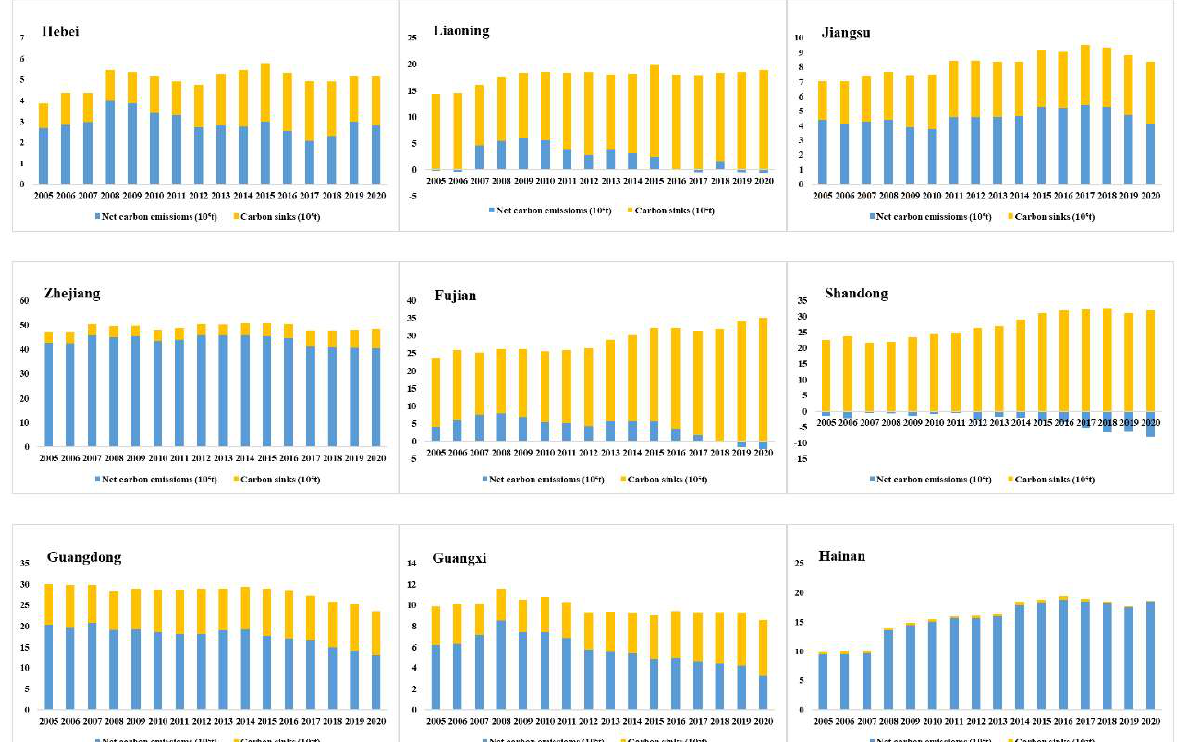
Figure 4. Changes in net carbon emissions in coastal provinces from 2005 to 2020.